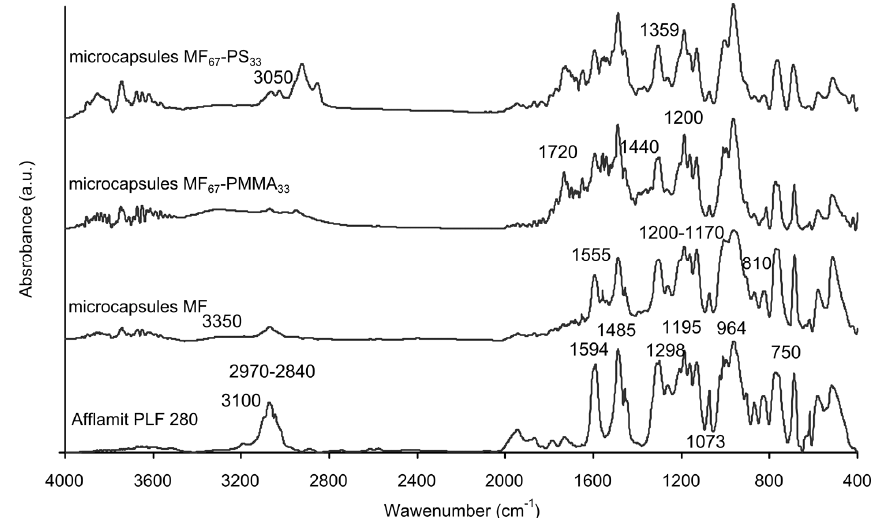
Figure 3. FTIR spectra of Afflamit PLF 280, MF microcapsules, MF 67 -PMMA 33 microcapsules, and MF 67 -PS 33 microcapsules. Table 2. Important peaks in the FTIR spectra and their